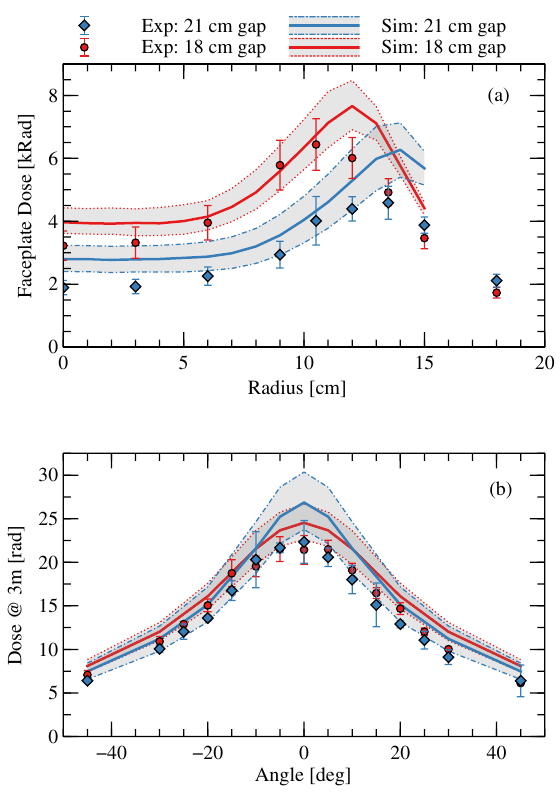
FIG. 6. Comparison of measured (points) and simulated (curves) doses from Case 0 simulations with both 18-cm and 21-cm AK gaps, in (a) the near field and (b) the far field. The faceplate dose in the 21-cm case peaks at larger radius, and the far field dose is more forward directed, both in experiment and